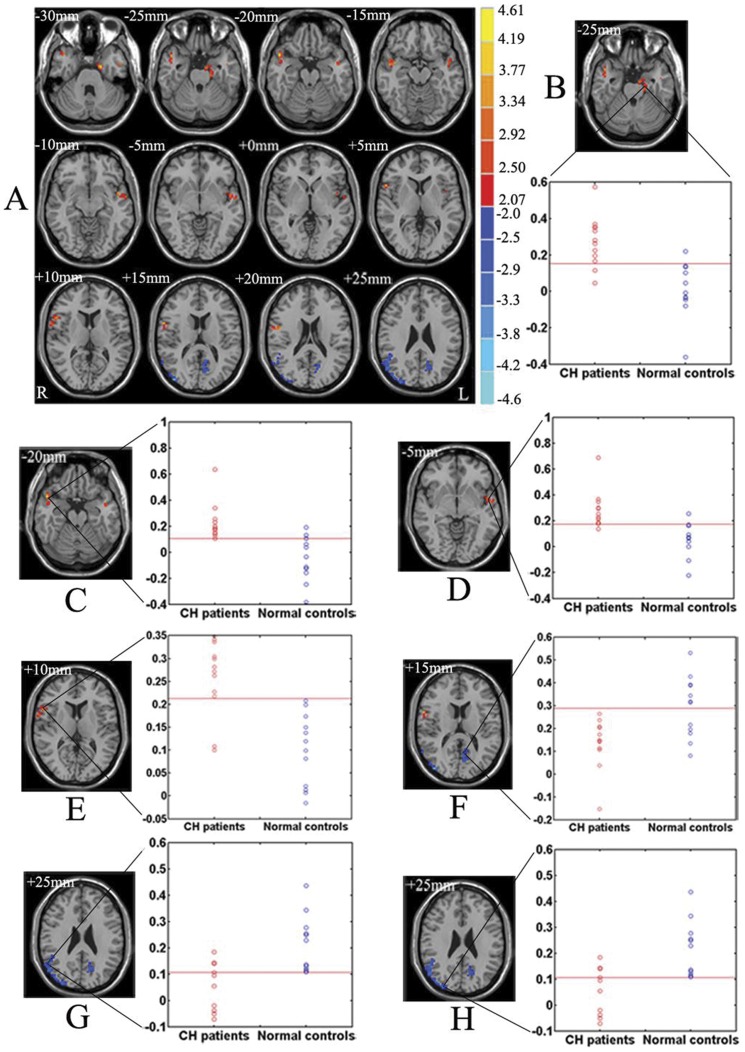
Altered functional connectivity of the hypothalamus and the mean functional connectivity with the right hypothalamus for each subject in CH patients during the ‘out of attack’ periods vs.that in normal controls. (A) Brain regions showing significantly increased (t-score>0) or decreased (t-score<0) functional connectivity with the right hypothalamus in CH patients during the ‘out of attack’ periods compared to that in normal controls, thresholded at P<0.05, corrected by Monte Carlo simulations. Color bar indicates the t-score. R, right; L, Left. Brain regions including the left parahippocampal gyrus and uncus (B), the right superior temporal gyrus, middle temporal gyrus and temporal pole (C), the left superior temporal gyrus, middle temporal gyrus, temporal pole, insula and fusiform gyrus (D), the right precentral gyrus and inferior frontal gyrus (E), the left occipital lobe, precuneus, inferior parietal lobule and cuneus (F), the right superior temporal gyrus, middle temporal gyrus and superior parietal lobule (G), and the right occipital lobe, precuneus, inferior parietal lobule and cuneus (H) showing the corresponding scattergram of the mean functional connectivity with the right hypothalamus for each subject in CH patients during the ‘out of attack’ periods and normal controls.